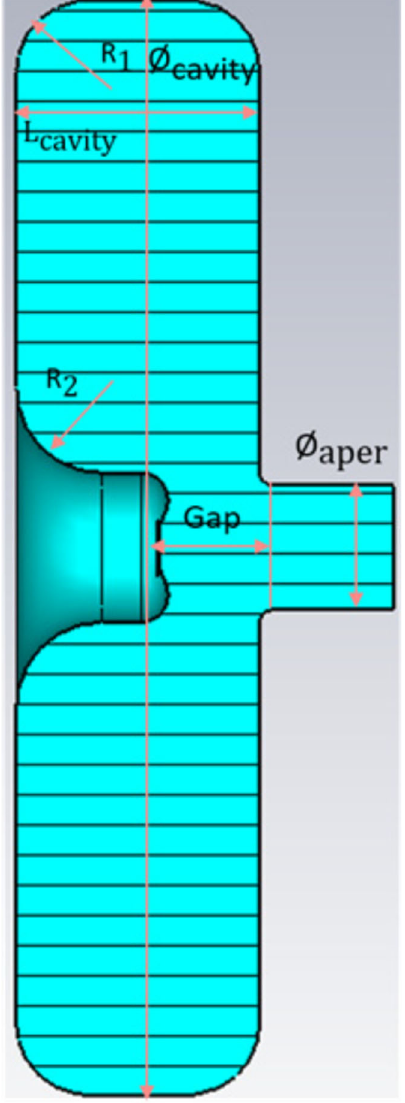
FIG. 3. Injector cavity design and operating parameters.